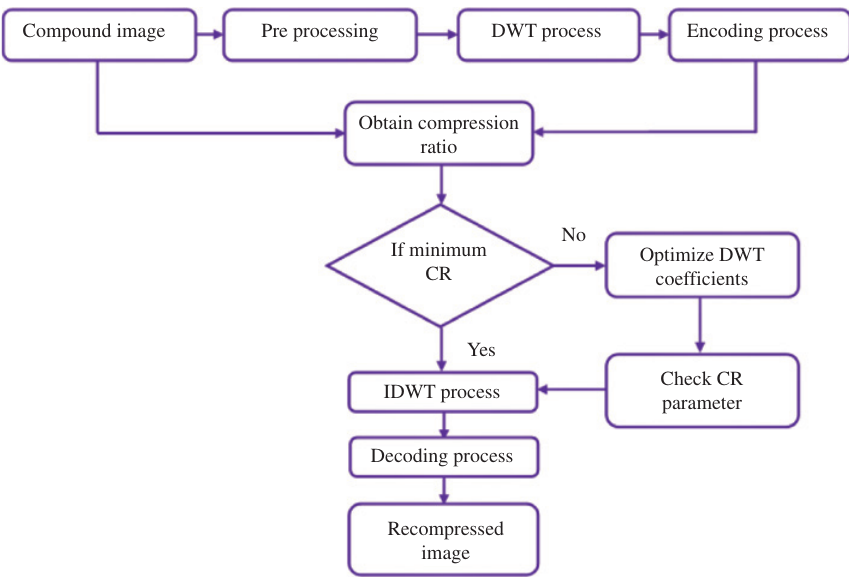
Figure 1: Block Diagram for Image Compression and Decompression